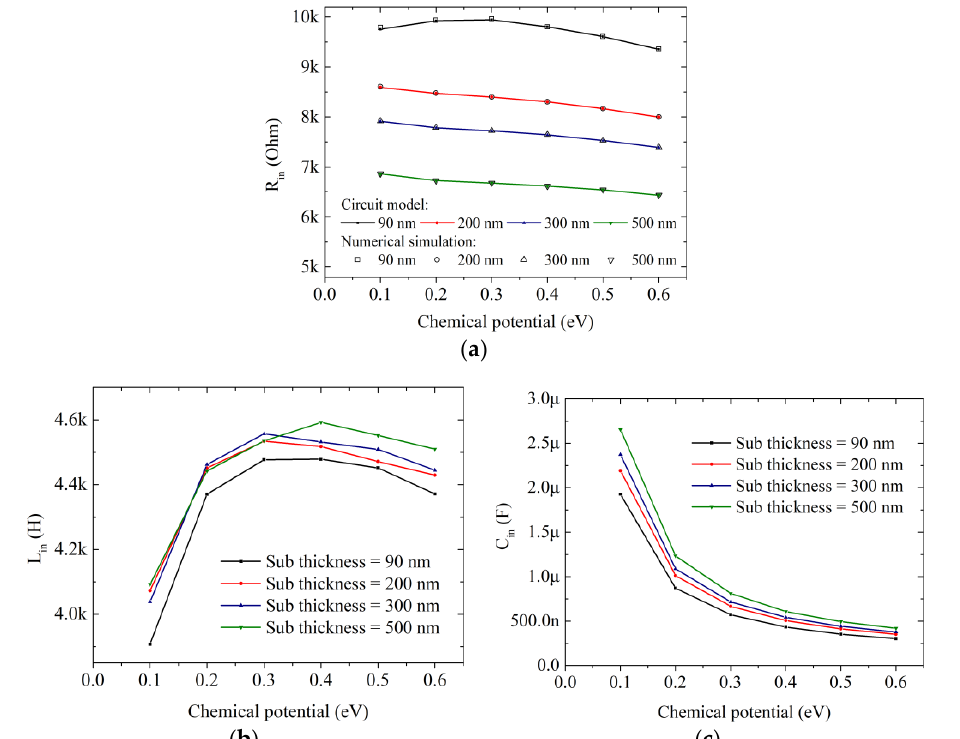
Figure 11. Equivalent circuit model parameters over chemical potentials. ( a ) R in , ( b ) L in , and ( c ) C in of the equivalent circuit against chemical potential with different substrate thickness values, 90 nm, 200 nm, 300 nm, and 500 nm. The relaxation time is 0.5 ps, the temperature is 300 K, and the arm length is 5 µm.